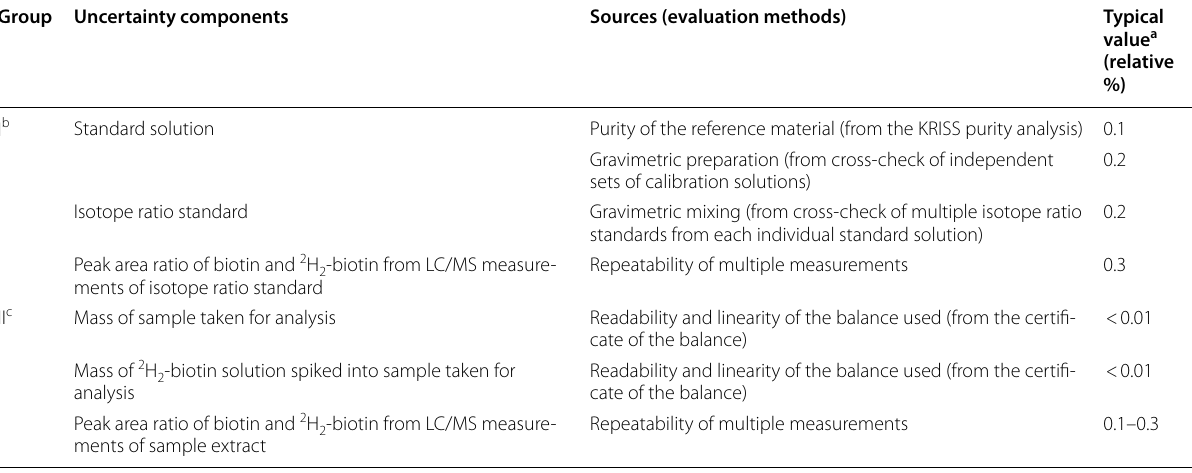
a Typical standard uncertainty of each source is based on the measurement protocol used in this study